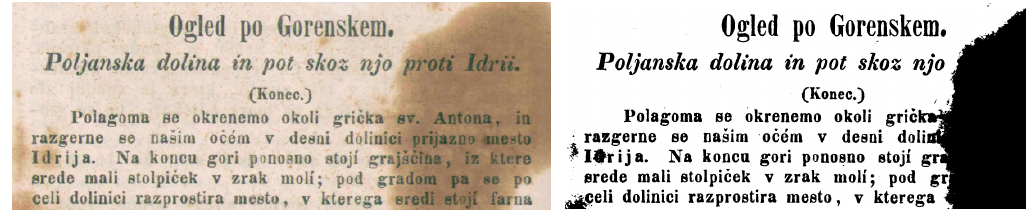
Figure 12. Example of Otsu-based binarization that fails to solve the problem of degradation.